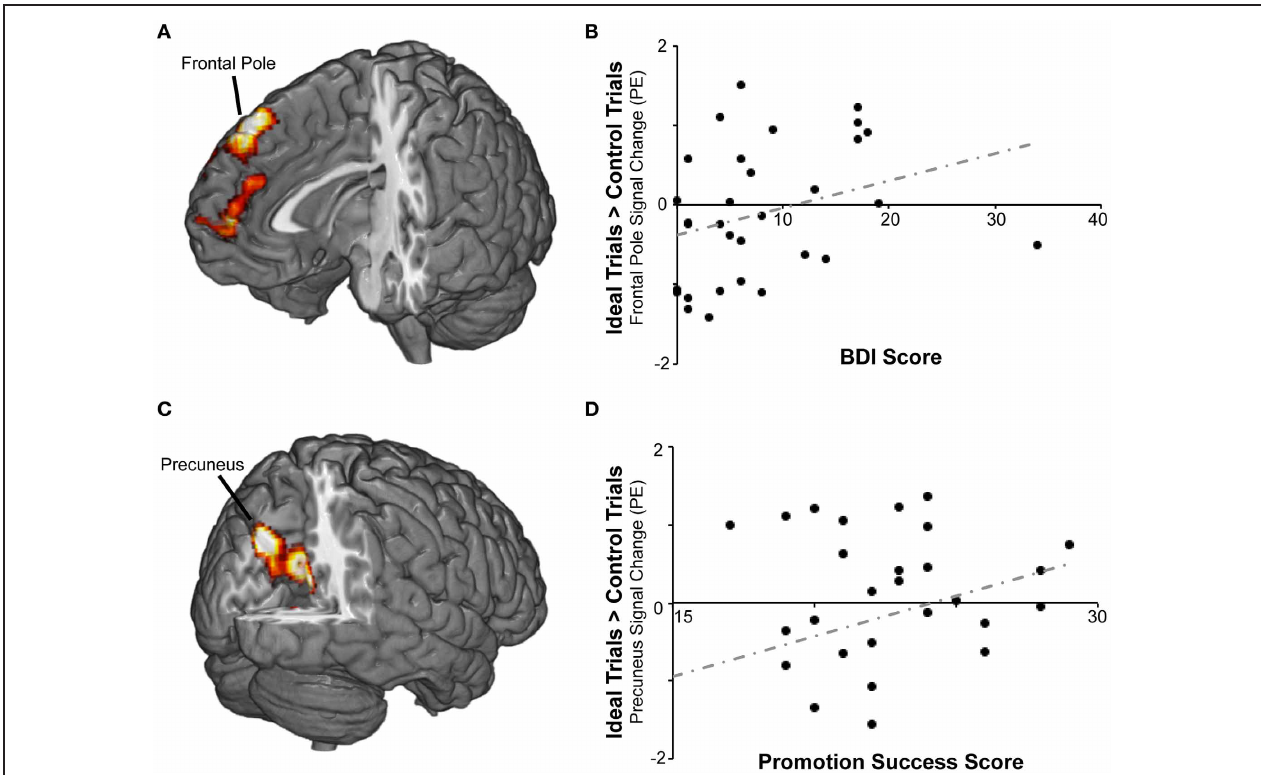
frontal pole ( x 8, y 40, z 52) as a function of symptom index scores. (C) For the ideal > control contrast, promotion success scores were positively correlated with activation in precuneus, posterior cingulate, and other regions. (D) The scatterplot displays mean standardized PEs at the left precuneus ( x − 8, y − 74, z 36) as a function of promotion success